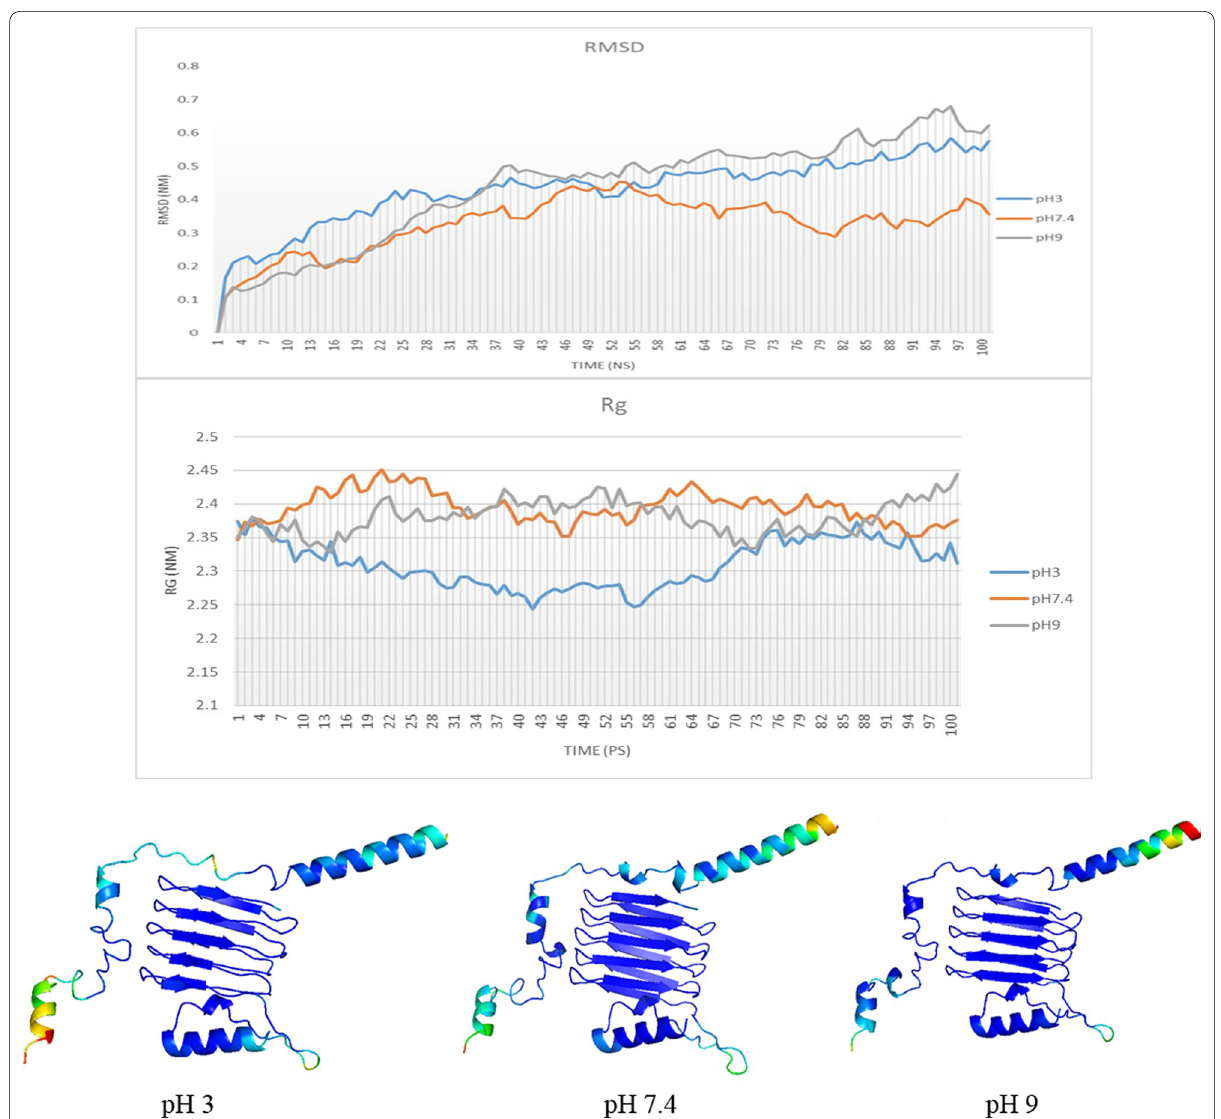
Fig. 6 The value of the root mean square deviation (RMSD) for each atom is determined with reference to the primary structure, which is the reference structure. It does this by contrasting the primary structure with the secondary structure at any given time and illustrating the degree to which they have changed. Rg, A measurement of protein compaction that indicates the degree to which the structure is stable when simulated at varying pHs. Using factor B in Paymol software, flexible parts that have a lot of movement were identified. The presence of a second regular structure (beta sheets) reduces the rate of change and flexibility at different pHs, as shown by the blue regions, which indicates this reduction in motion. Red regions is associated with transition, movement and